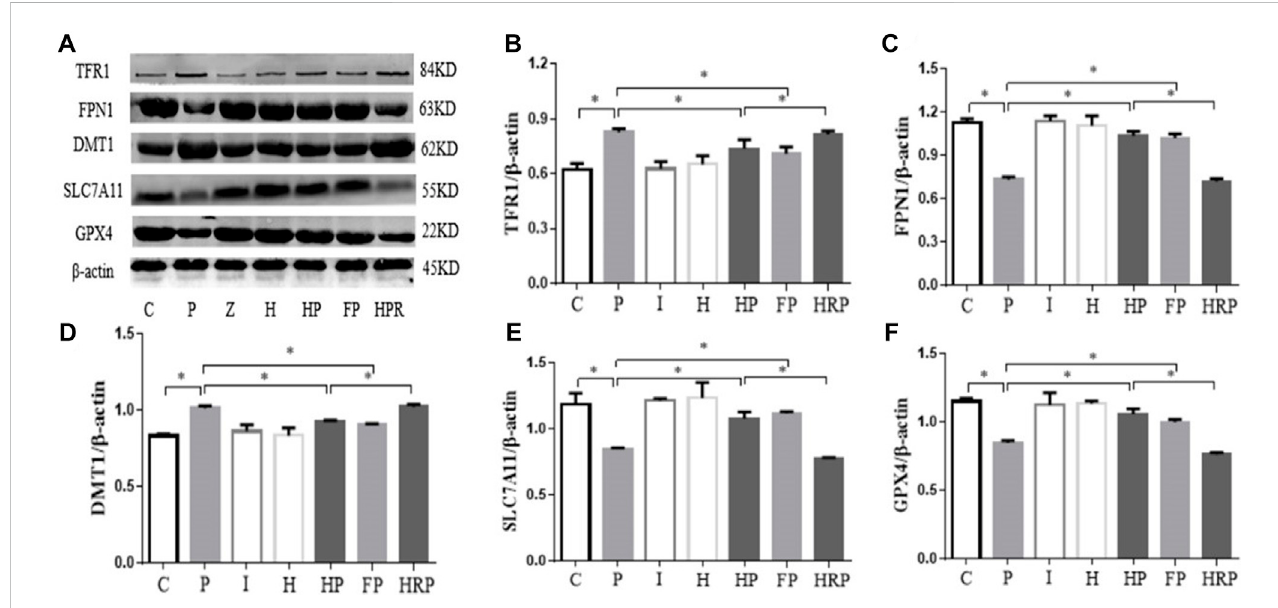
FIGURE 9 Protein expression levels of TFR1, FPN1, DMT1, SLC7A11 and GPX4 in primary hippocampal neurons exposed to propofol with or without hypoxic preconditioning, inhibitor or agonist. (A) TFR1, FPN1, DMT1, SLC7A11 and GPX4 protein expression was detected by Western blot analysis. (B – F) Quantitative analysis of the ratio of TFR1, FPN1, DMT1, SLC7A11 and GPX4 to β -actin (one-way ANOVA, * p <